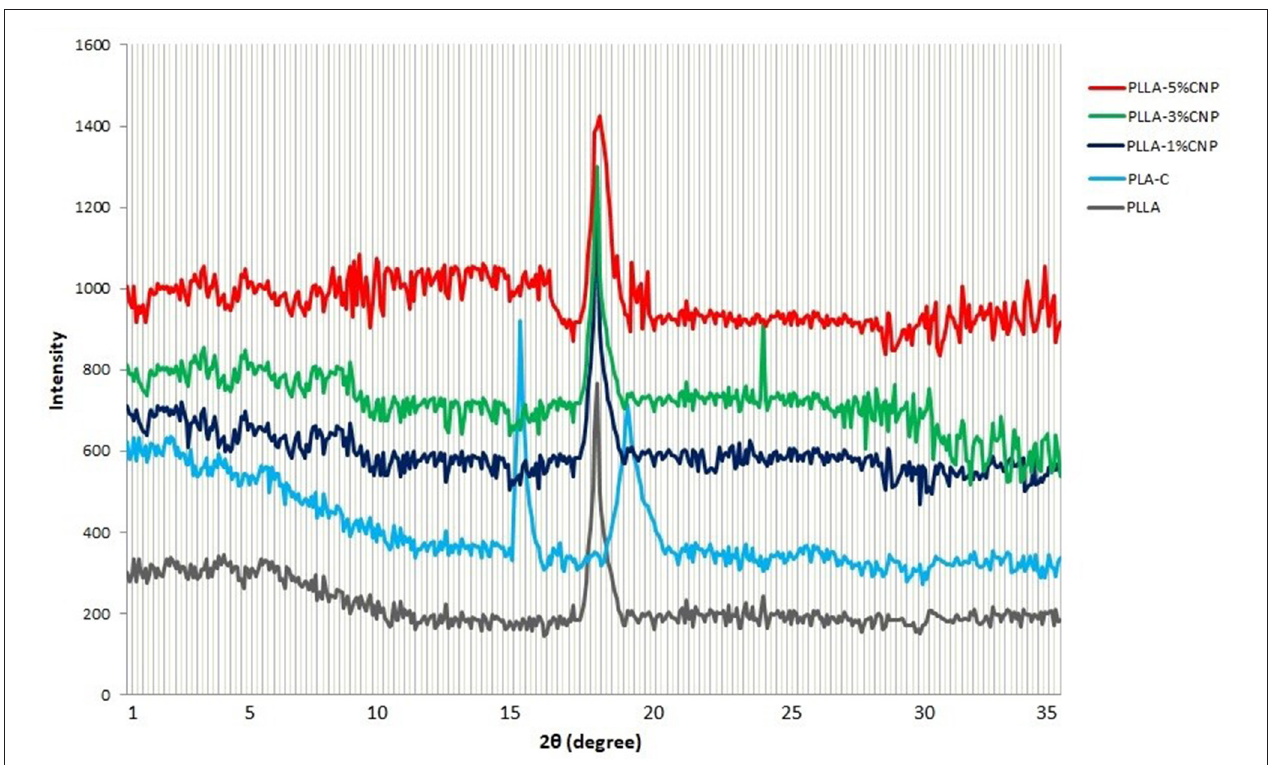
FIGURE 5 | X-ray diffraction patterns of commercial PLA films (PLA-C), PLA films manufactured from fermentation process (poly(L-lactic acid) (PLLA)), PLLA-1% CNPs, PLLA-3% CNPs, PLLA-5%